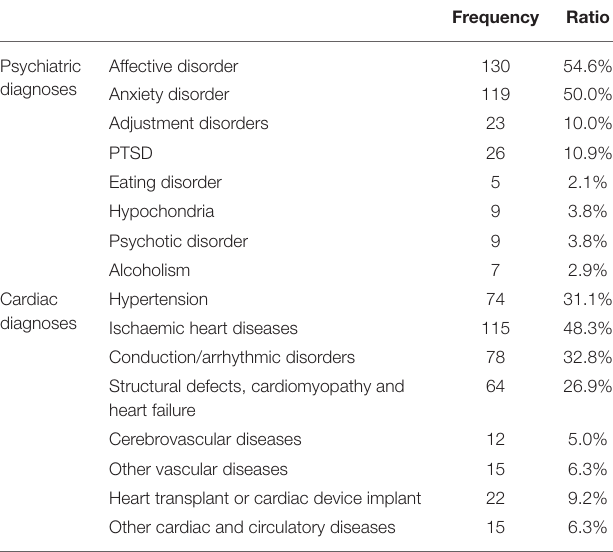
TABLE 2 | Psychiatric and cardiac diagnoses in the sample ( N =